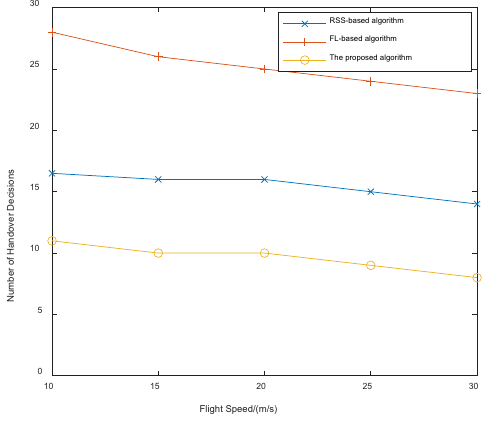
Fig. 8. Total number of handovers versus flight